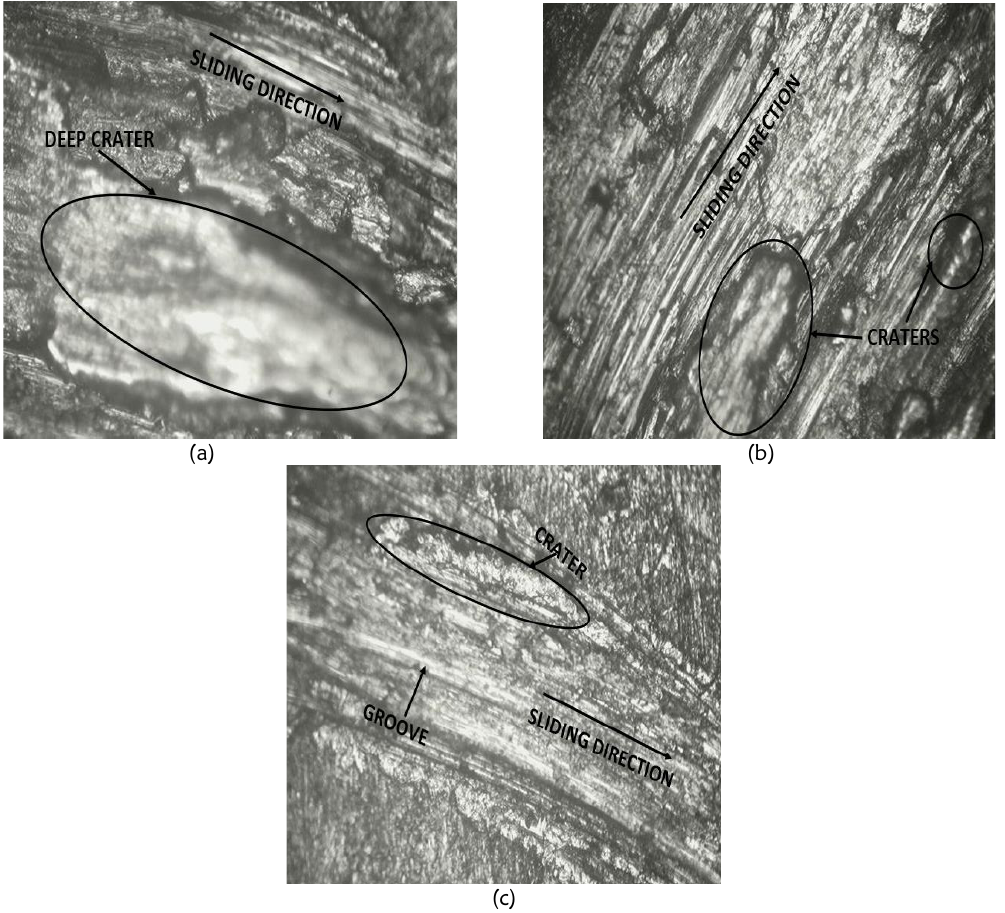
Figure 9: Micrograph wear worn surfaces of (a) AA6061 alloy, (b) AA6061/2.5 wt.% oxidized-SiC p composite and (c) AA6061/10 wt.% oxidized-SiC p